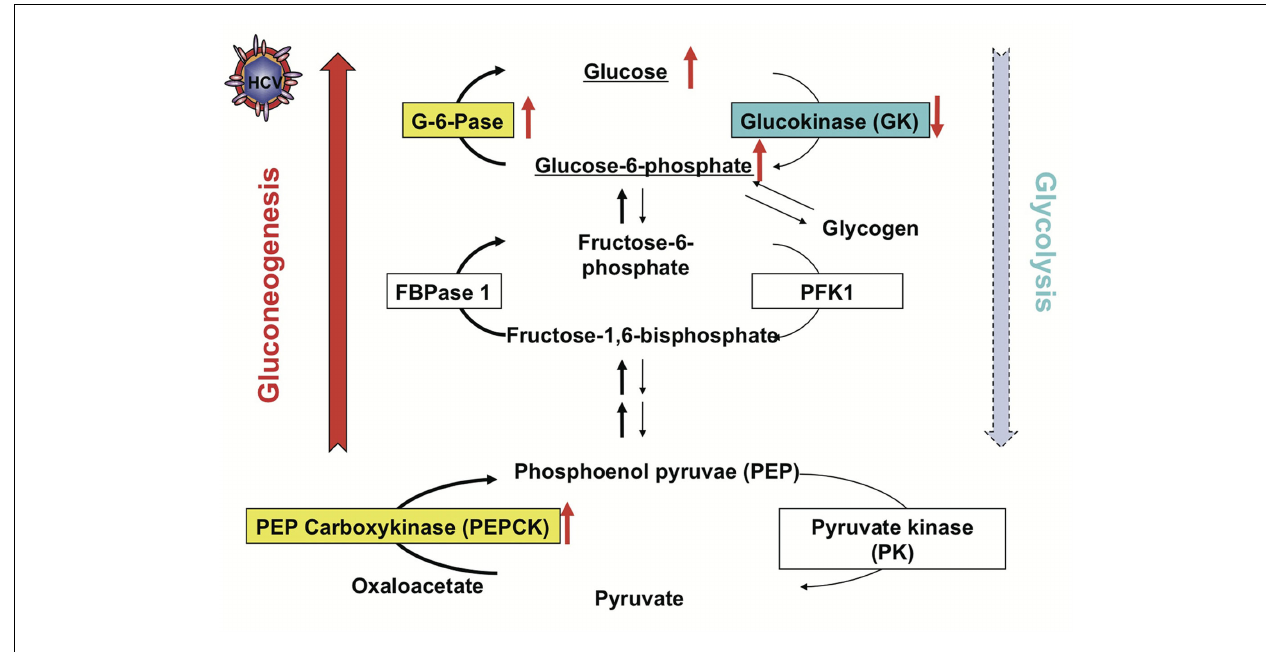
rate-limiting enzymes for hepatic gluconeogenesis, and transcriptional down-regulation of the gene for GK, the rate-limiting enzyme for hepatic